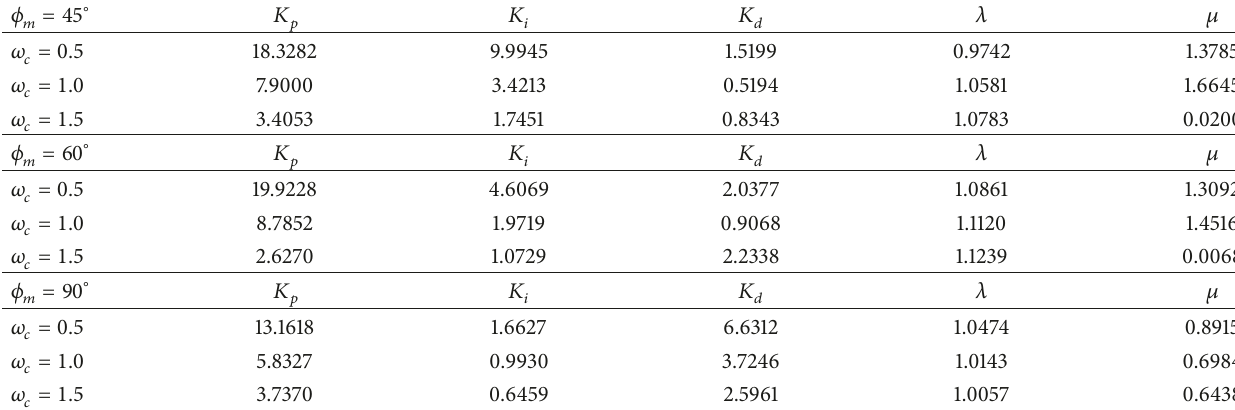
Table 2: Controller parameters of 𝑃 2 (𝑠)